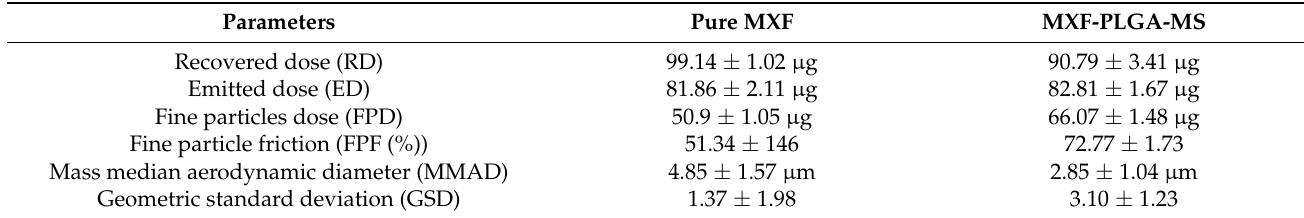
Table 3. Aerodynamic parameters of free MXF and optimized MXF-PLGA-MS.